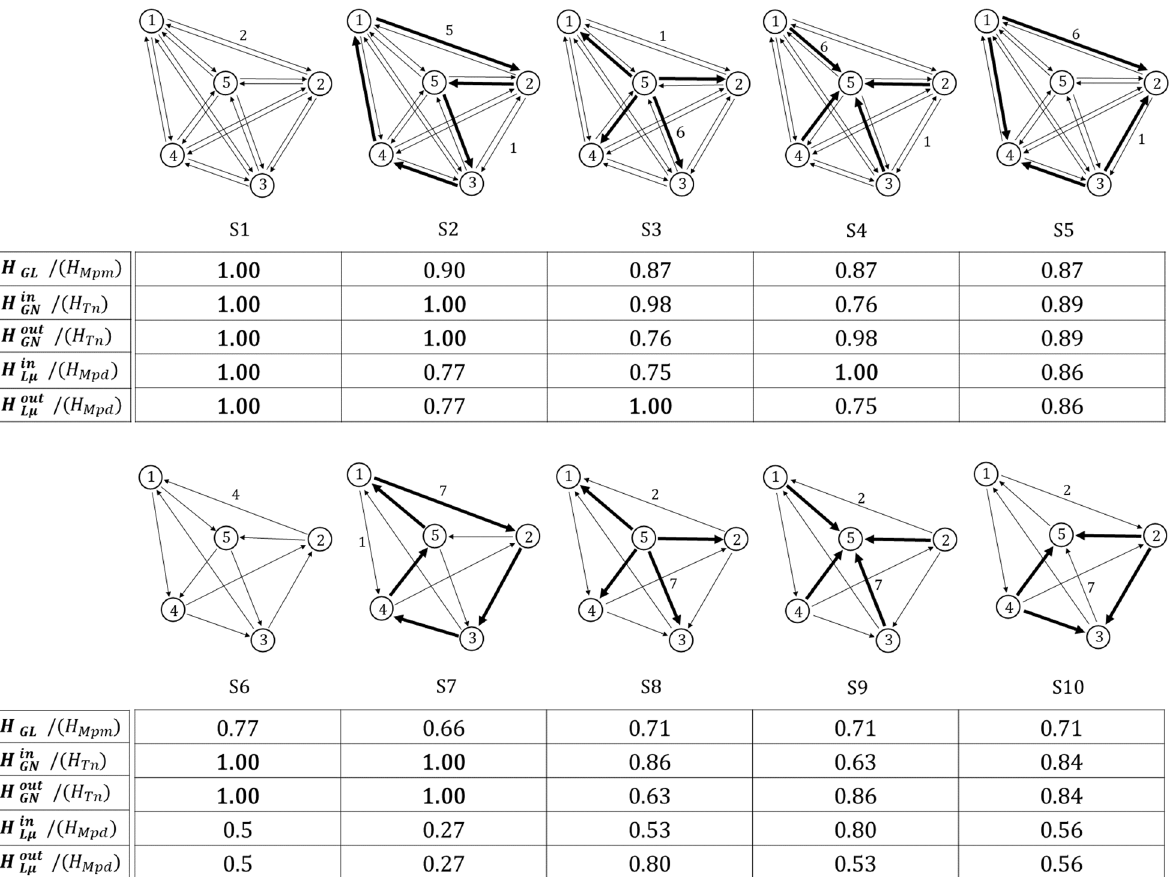
Figure 4. Global and local measures across different commuting networks. Values correspond to normalised entropy. The total volume of trips is 40 flows in all systems. The link density D for S 1 to S 5 is 1.0 and for S 6 to S 10 is